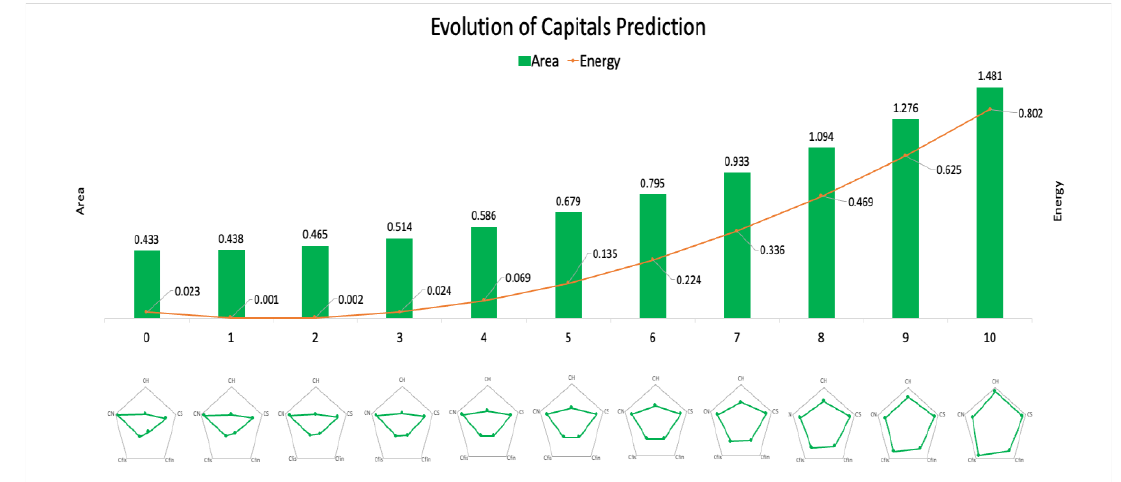
Figure 7. Forecast of the evolution of capitals.